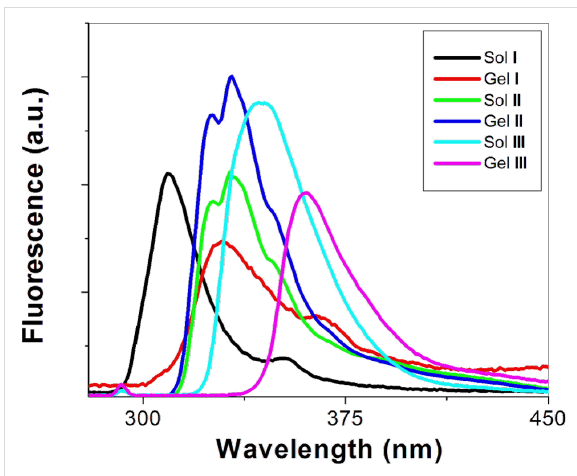
Figure 5: The emission spectra (slit width = 3.0 nm) of the gels I – III and their solutions ( I : λ ex = 265 nm; II , III : λ ex = 292